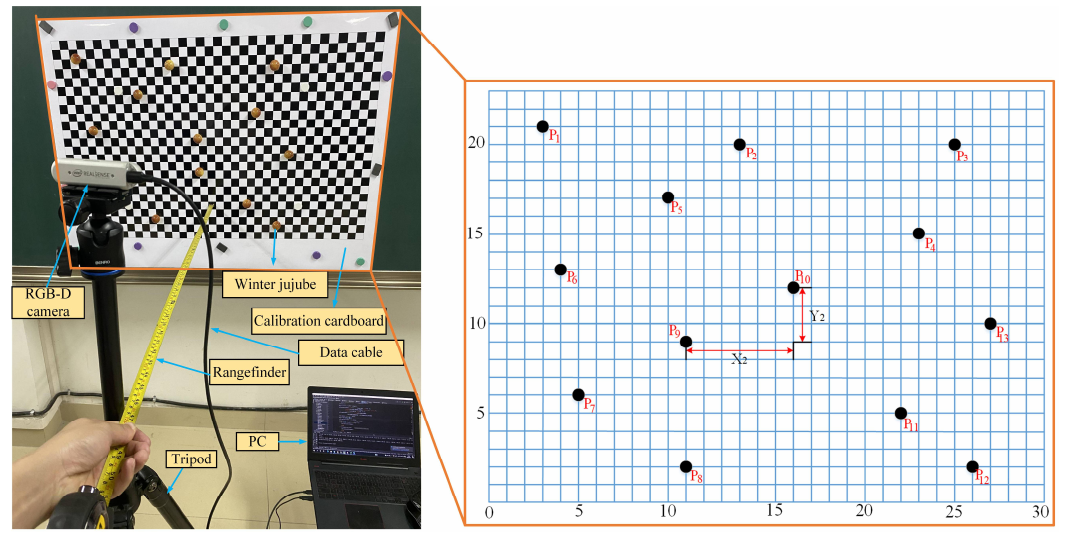
Figure 3. Winter jujube localization system.